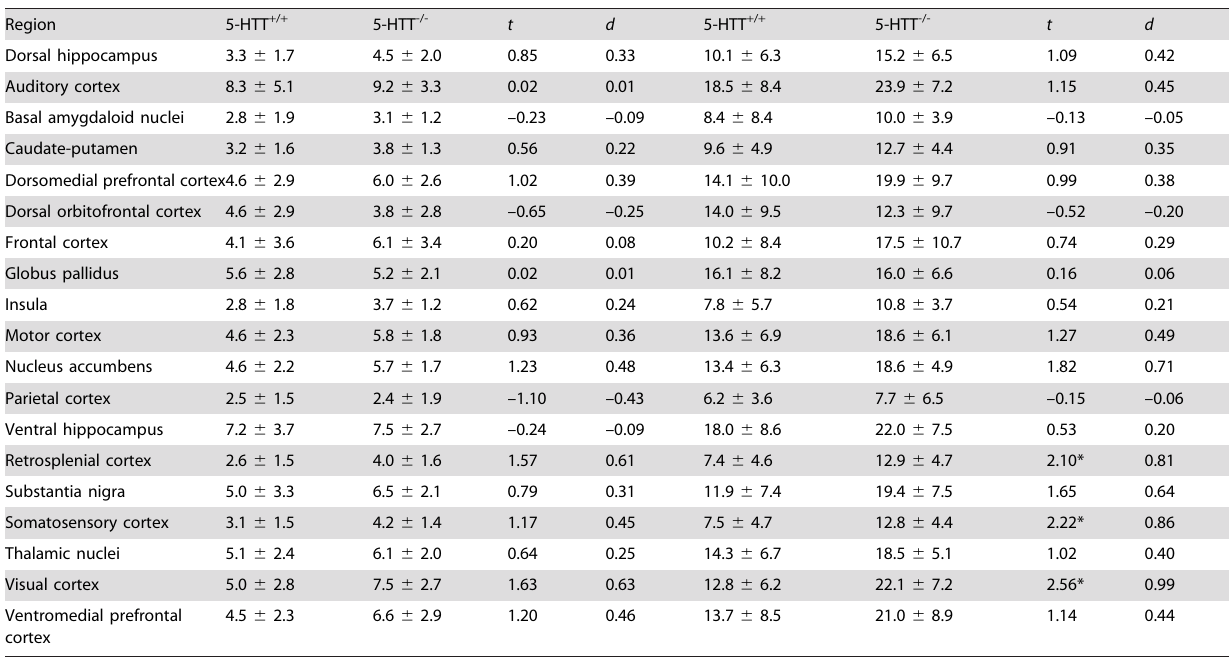
Maximum of the BOLD response, relative to baseline (%)Area under the curve (a.u.)